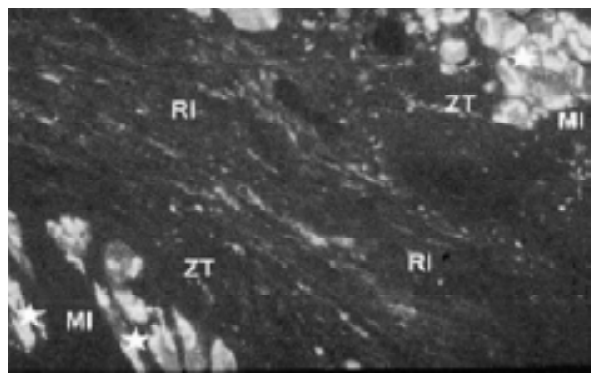
Fig. 10 - Immunofluorescence of the conexin-43 protein. Conexin-43 is not identified in the transition zone (zt) and in the central region (ri) of the slide, where the transplanted skeletal muscle fibers can be identified. Notice the presence of conexin-43 (stars) only in the integral myocardium (mi) (magnification